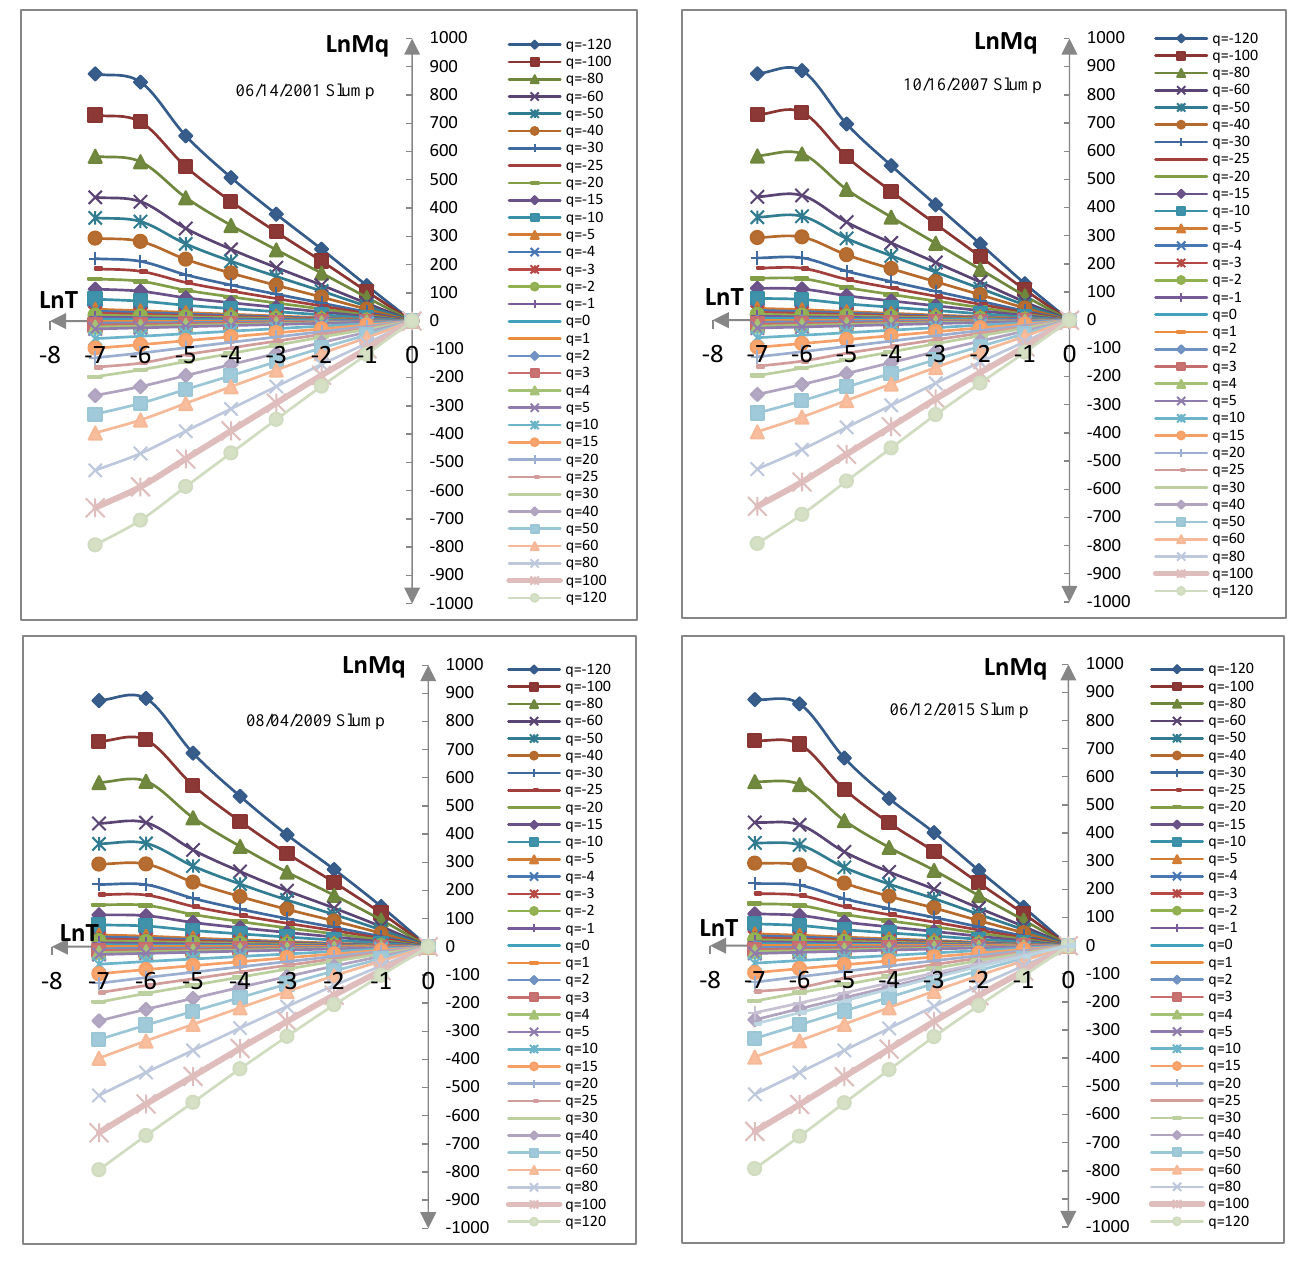
Figure 1. Curves of lnMq(T) vs. ln(T) with different values of q. It can be seen from Figure 1 that no matter what value q takes, lnMq(T) ~ lnT has a good linear relationship and shows scale invariance when |lnT|< 5. This result is strong evidence of the existence of a multi-scale relationship in the SSECI time series, indicating that the price fluctuation of each scale obeys the multifractal random walk. Figure 2 gives the generalized correlation dimensions Dq with different values of q.